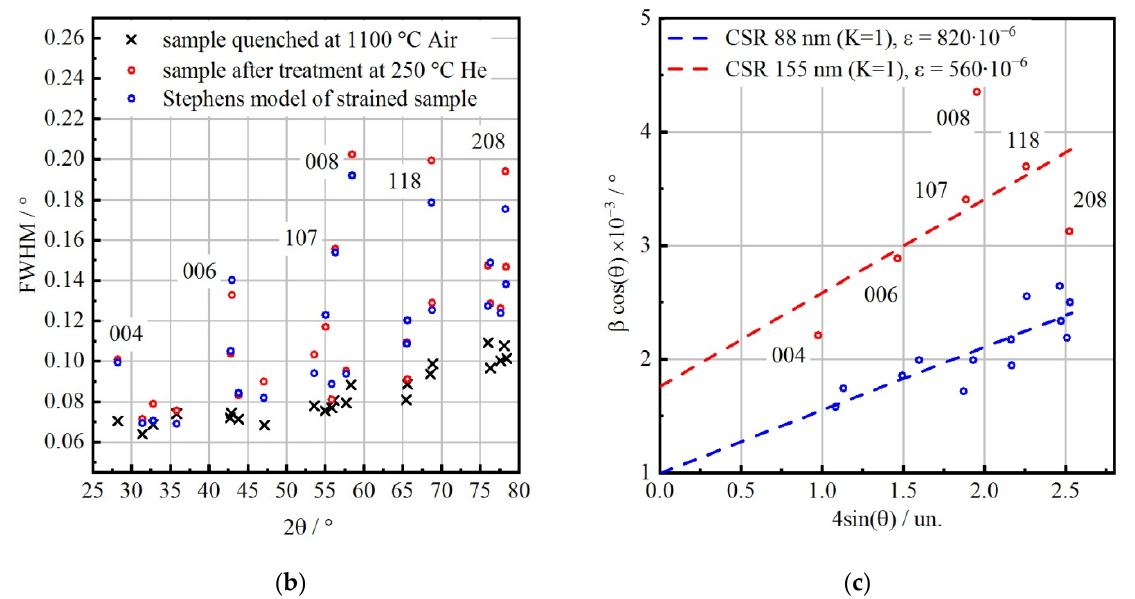
Figure 3. Three-dimensional strain distributions derived from Stephens’s model [44] in GSAS-II software [43] for LCNO_01_q after treatment in He at 250 °C (LCNO_01_t)—( a ); FWHM versus 2 θ for experimental diffraction profiles LCNO_01_q (black crosses), LCNO_01_t (red circles) and for fitted diffraction profile (blue circles, Stephens’s model [44])—( b ); Williamson Hall plot for 00l and hkl (for high l and low h/k) reflections (red circles) and others reflections (blue circles) for LCNO_01_t sample—( c ). β —integral breadth.